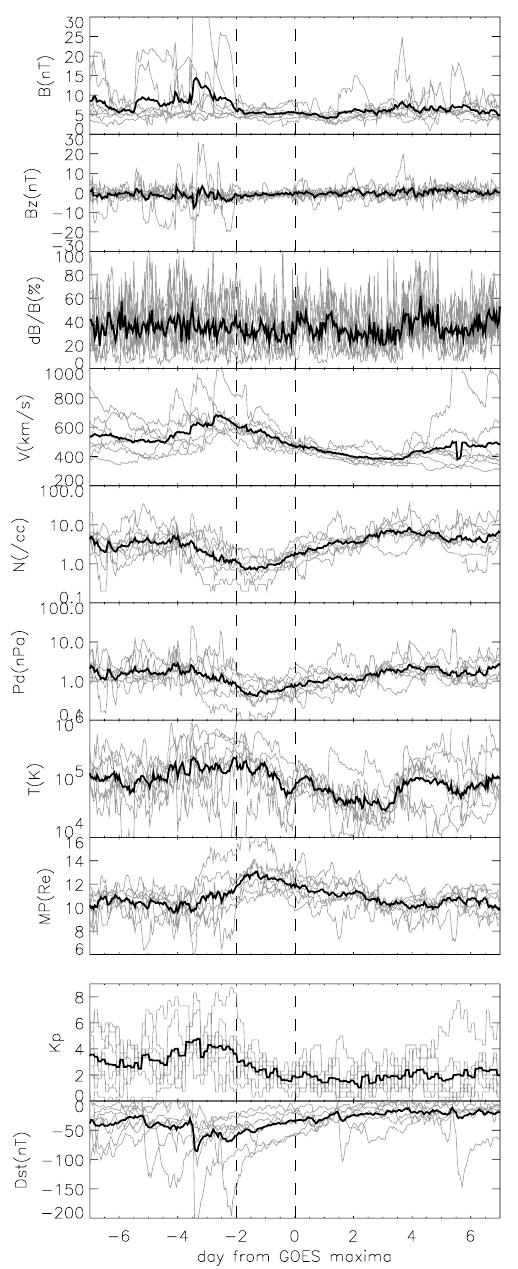
Fig. 1. Average profiles of solar wind parameters and geomagnetic activities during extreme events superposed at 17:00UT of the day of maximum flux enhancement: From top to bottom, shown are in- terplanetary magnetic field strength B , the southward component B z in the GSM coordinate system, magnetic field fluctuation level dB/B , solar wind speed V , proton number density N , dynamic pres- sure Pd , proton temperature T , subsolar magnetopause distance MP , K p index, and D st index. Light gray curves show the pro- files of each event. Vertical dashed lines indicate the period when the dynamic pressure has very low value of < 1.0nPa.